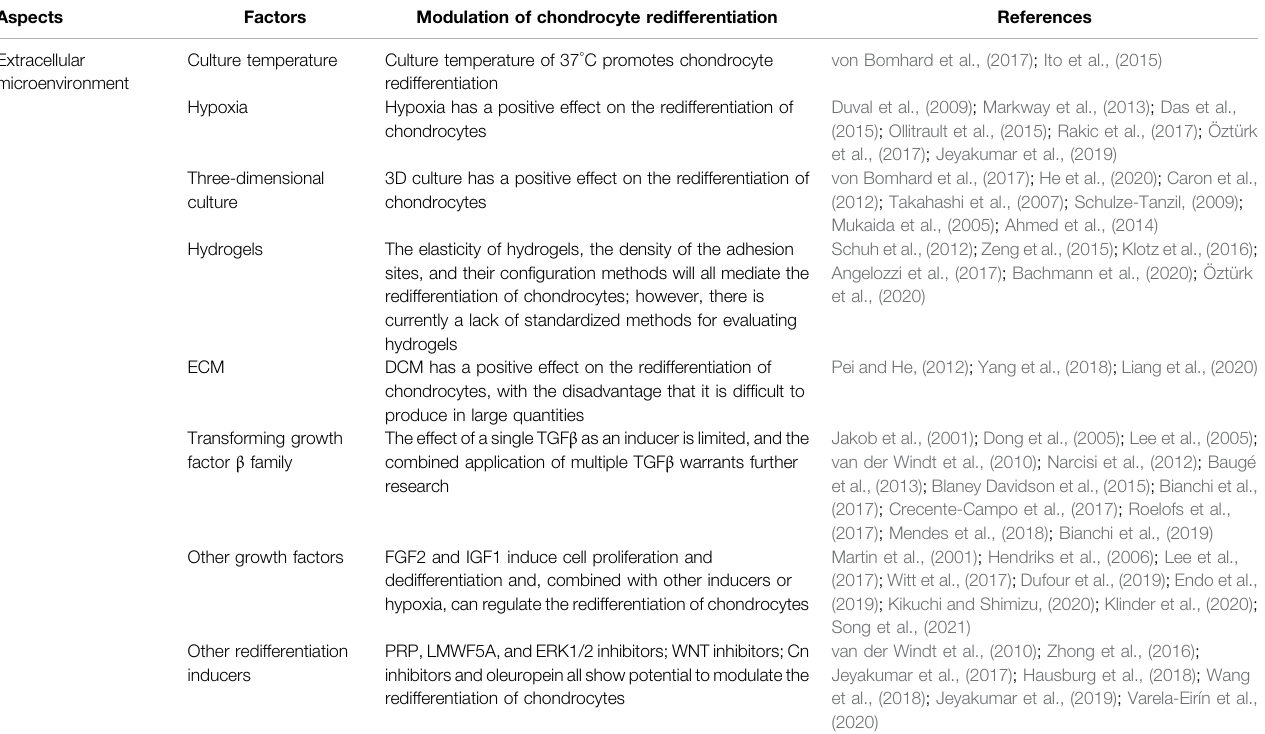
TABLE 2 | Various factors in the extracellular microenvironment modulate the redifferentiation of chondrocytes.